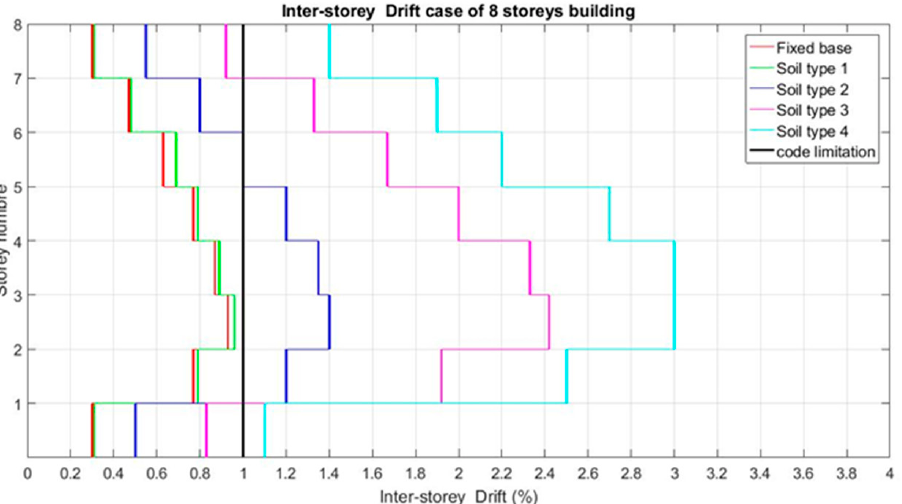
Figure 9. Inter-story drift case of an 8-story building .